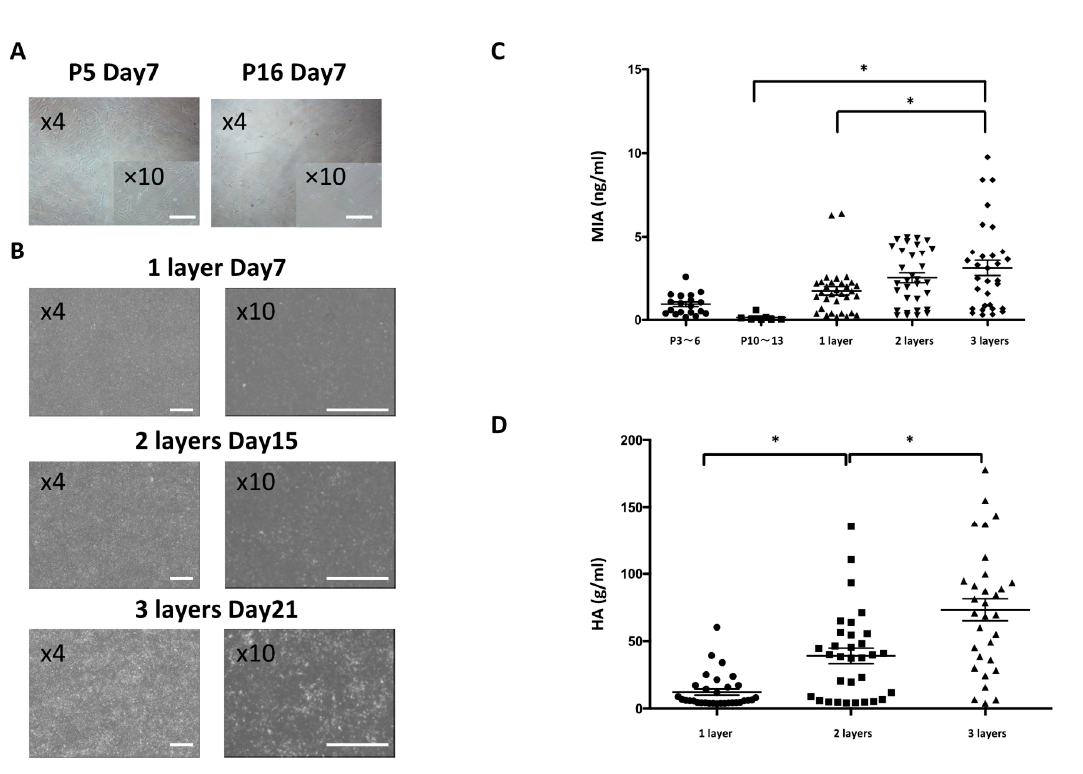
Figure 2. Chondrocyte progenitor cell multilayer culture. ( A ) Culture images of chondrocyte progenitor cells passaged 5 and 16 times. Scale Bars: 500 µ m. ( B ) Culture images of chondrocyte progenitor cells in multilayer culture numbers 1 to 3. ( C ) Measurement of melanoma-inhibiting activity (MIA) during subculture and layered culture of chondrocyte progenitor cells. Holm–Sidak multiple comparisons test: * p < 0.01 vs. 2D culture and layer number ( n = 7–26). ( D ) Measurement of hyaluronic acid secretion by layered culture. Holm–Sidak multiple comparisons test: * p < 0.01 vs. layer number ( n = 26)